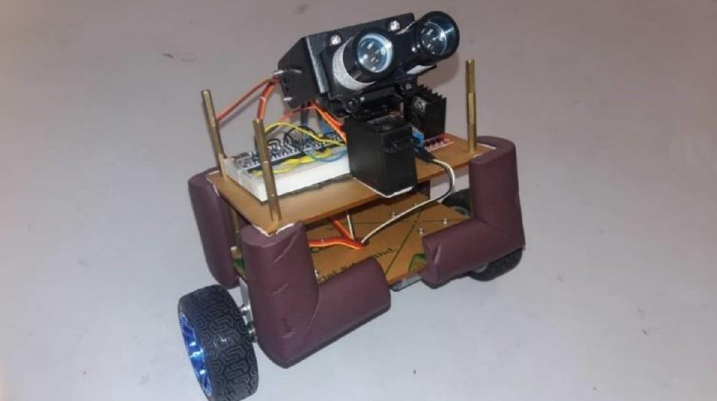
Fig 1. Mobile robot prototype with a single actuating LiDAR sensor for object